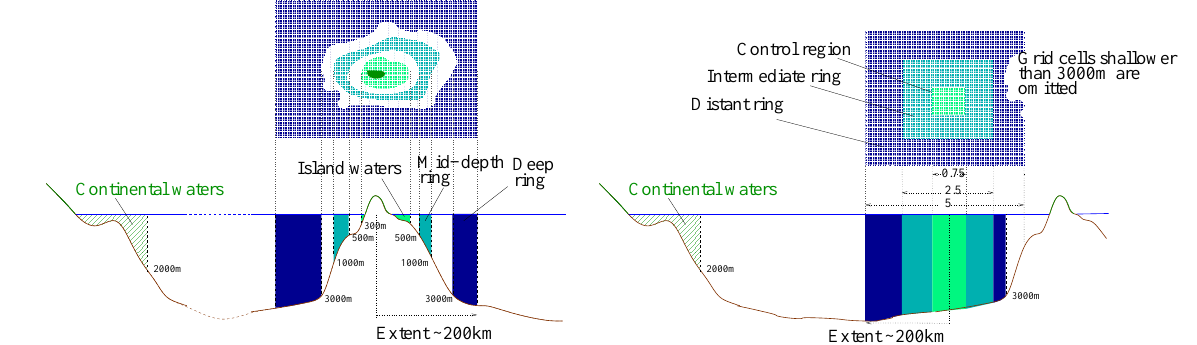
Fig. 1. Illustration of island waters and surrounding rings, and control regions.